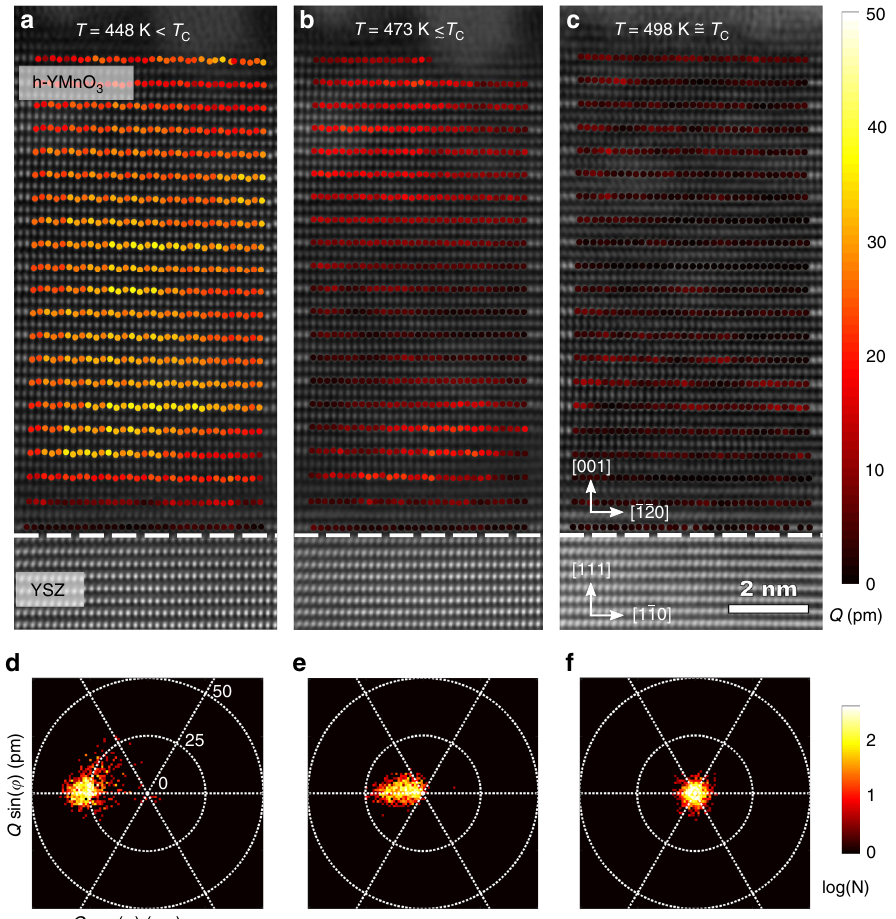
Fig. 2 Real-space visualization of the lattice trimerization amplitude Q across the ferroelectric phase transition. a – c HAADF-STEM images of a 10-unit-cell YMnO 3 thin fi lm overlayed with the spatial distribution of the trimerization amplitude Q at the temperatures T = 448 K ( a ), 473 K ( b ), and 498 K ( c ), with T = 498 K as phase transition temperature. d – f Histogram plots showing the number of occurences N of the Q and φ values (de fi ned in Fig. 1a) for each Q temperature in a – c ,